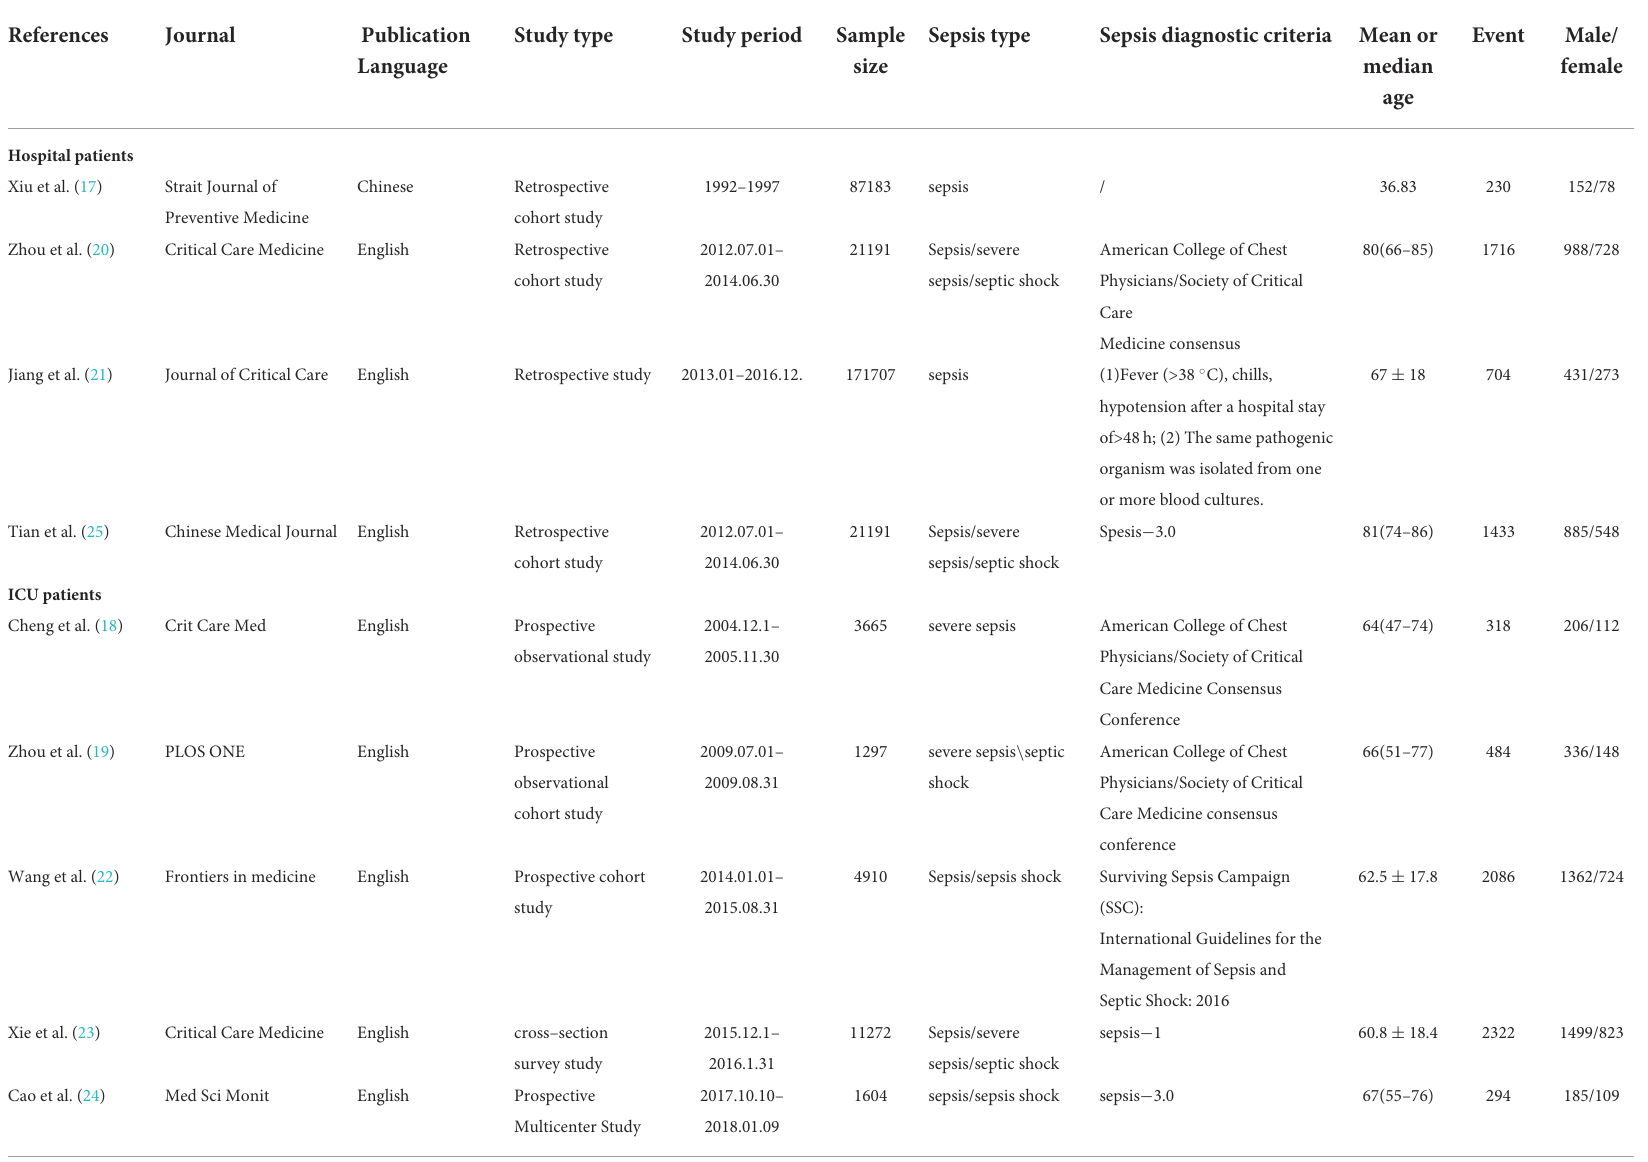
TABLE 1 Characteristics of studies included in the